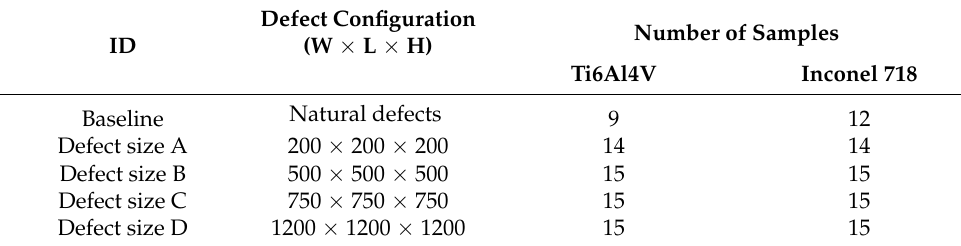
Table 1. Defect scenario configuration; dimensions are reported in µ m. The baseline scenario represents the HIP-treated samples with the normal porosity level obtained from the process adopted. Defect Configuration Number of Samples ID (W × L × H) Ti6Al4V Inconel 718 Baseline Natural defects 9 12 Defect size A 200 × 200 × 200 14 14 Defect size B 500 × 500 × 500 Defect size C 750 × 750 × 750 Defect size D 1200 × 1200 ×